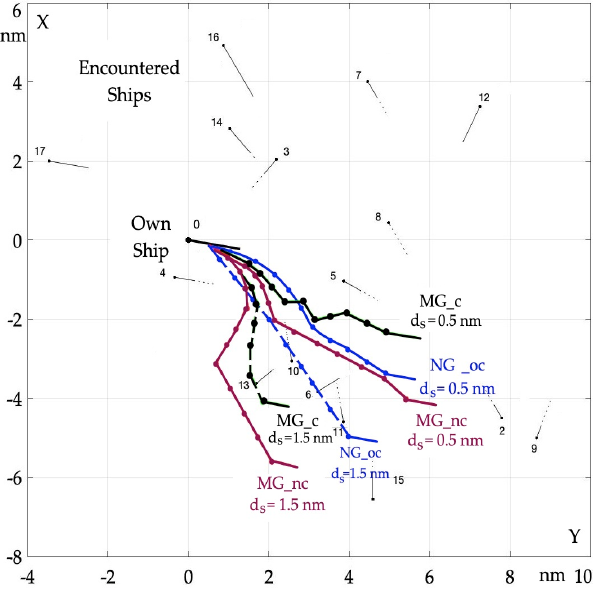
Figure 13. Comparison of autonomous surface ship safe paths when passing K = 17 encountered other autonomous surface ships in good ( d s = 0.5 nm) and restricted ( d s = 1.5 nm) visibility at sea, determined by the MG_c, MG_nc, and NG_oc algorithms. 217